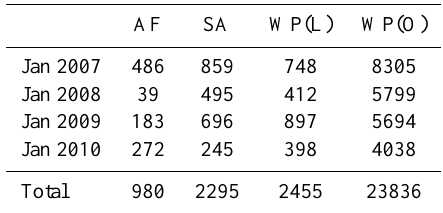
Table 1. The numbers of MODIS–CloudSat collocated DCC pixels over the four analysis domains. In January, only 15 days of data are available because of the battery problem of